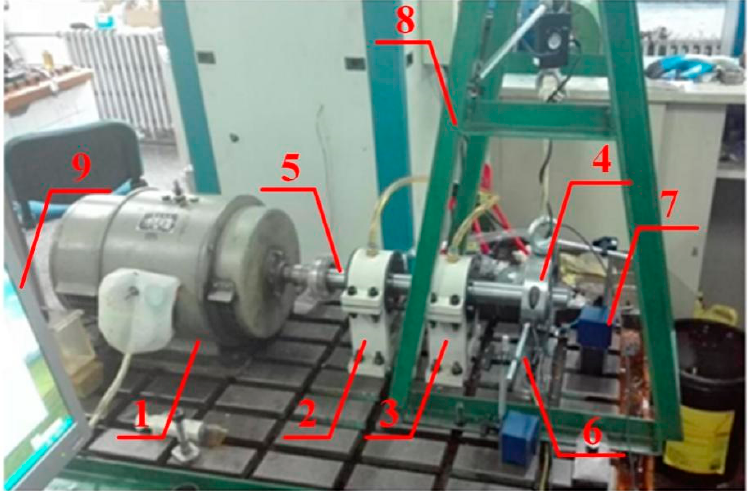
Figure 7. Test rig. 1 electrical machine; 2–3 sliding bearings for supporting; 4 SRBs pedestal with self-aligning function; 5 rotor; 6–7 displacement sensors; 8 loading equipment; 9